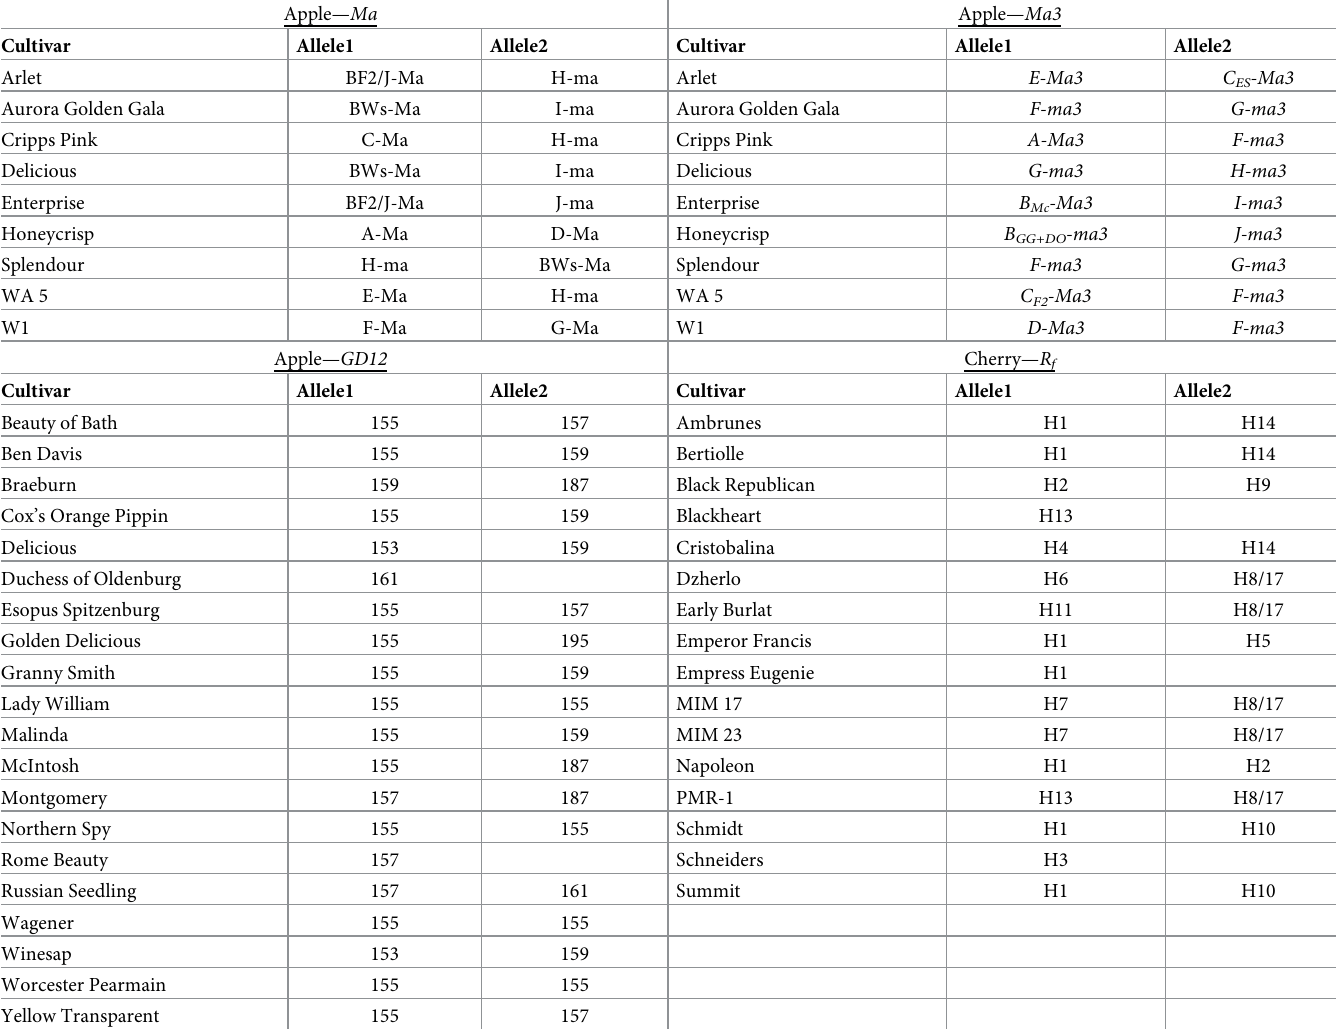
Table 1. Reference panel individuals and their locus genotypes used to assign historically reported alleles to SNP haplotype patterns. Apple—